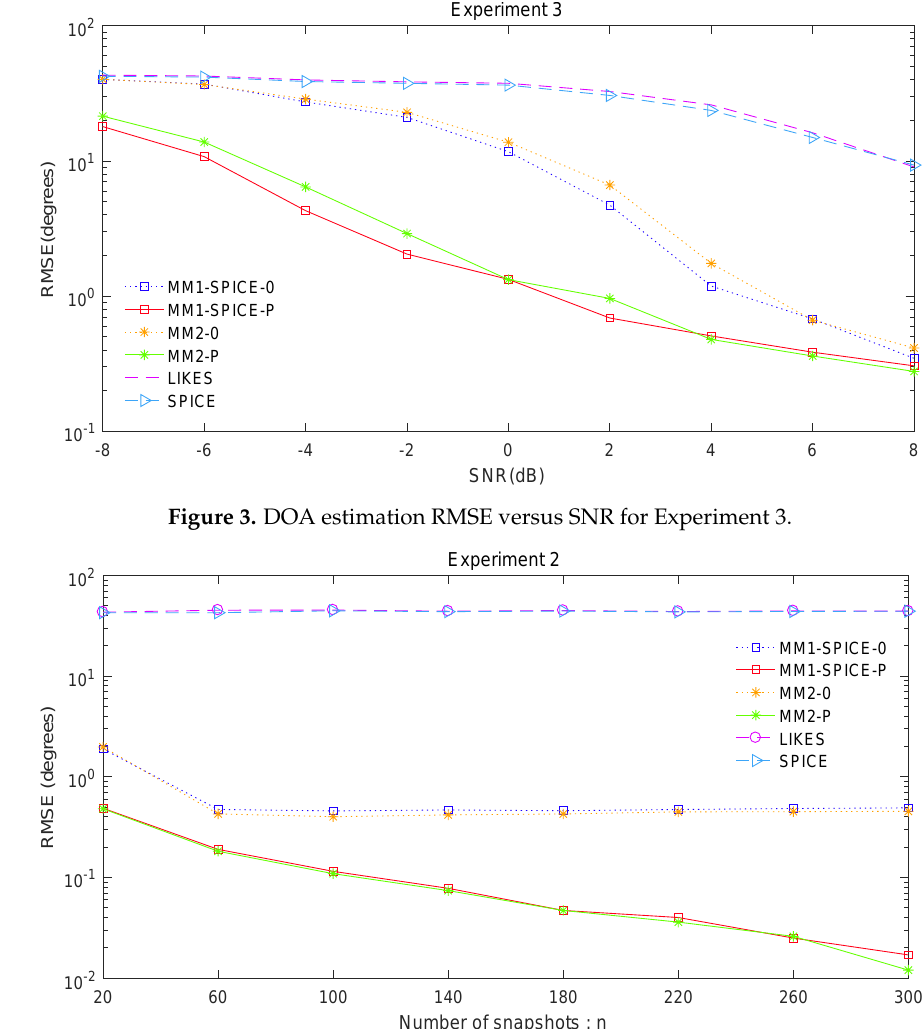
Figure 4. DOA estimation RMSE versus the number of snapshots n for Experiment 2 with SNR = 0dB and ∆ ξ = 15 ◦ .